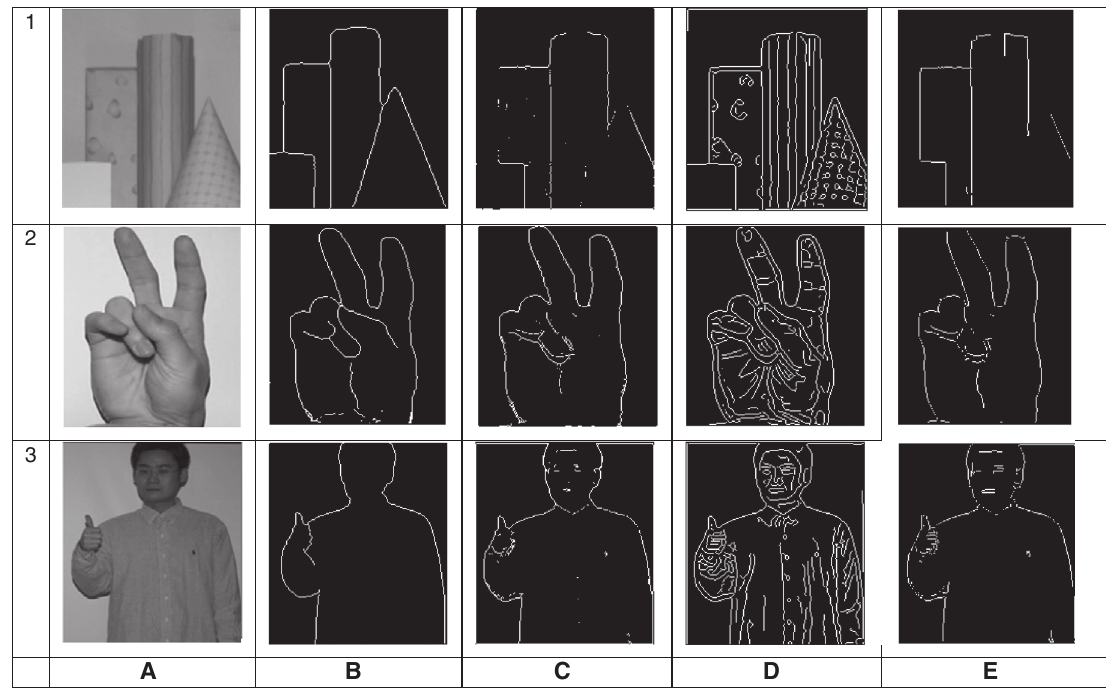
Figure 6. Further Experimental Results for Various Images. (A) Original image [6]; (B) ground-truth edges; (C) proposed method; (D) Canny method; and (E) Canny–Deriche